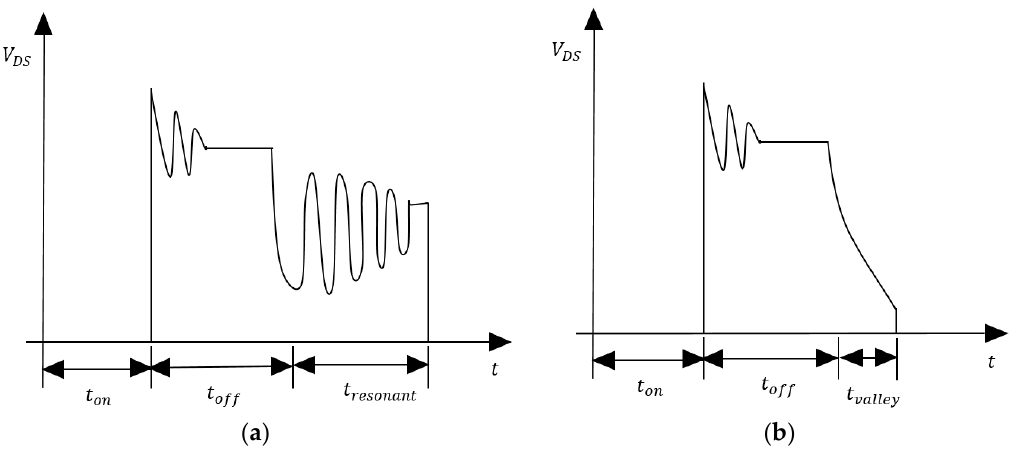
Figure 2. Drain-source voltage of the power switch used in a discontinuous conduction mode (DCM) fly-back converter and quasi-resonant fly-back (QRF) converter with a discontinuous conduction mode: ( a ) drain-source voltage of the power switch in the DCM fly-back mode and ( b ) drain-source voltage of the power switch in the QRF operation mode.